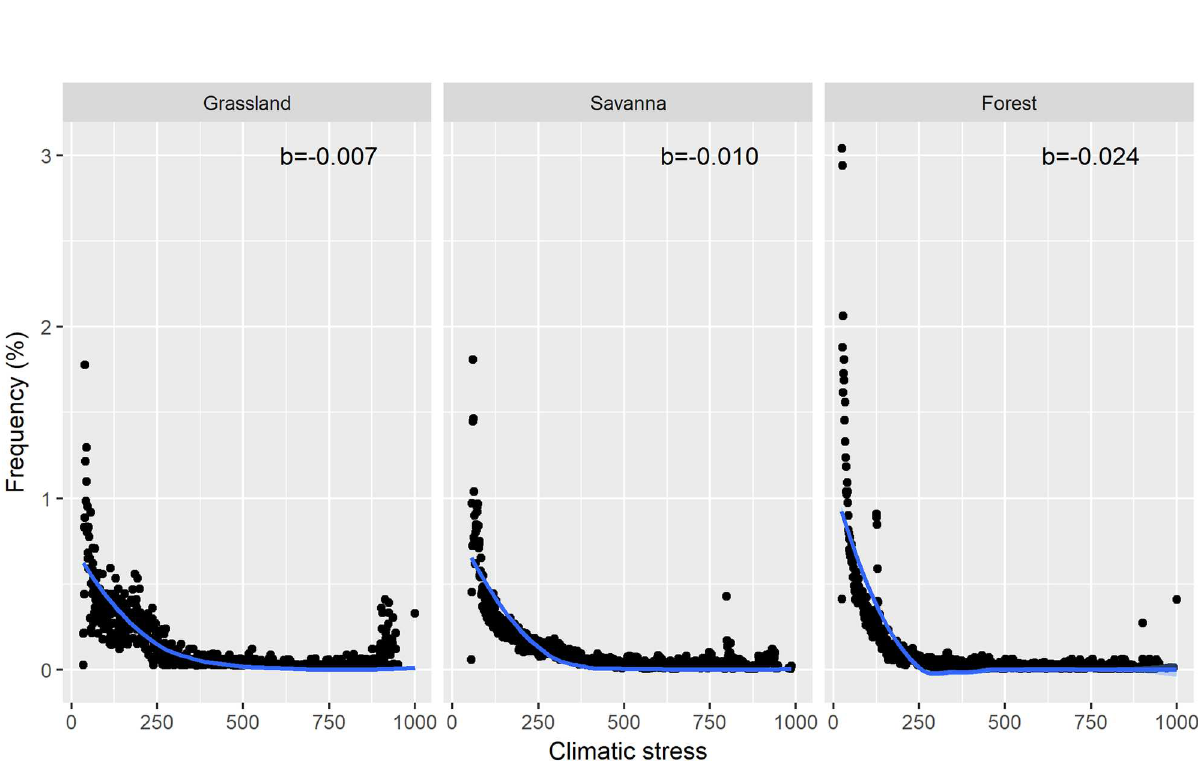
Fig 2. Model of ecosystem responses to a climate stress gradient based on the prediction of relative frequencies (%). The parameters of the exponential model indicate that there are differences regarding resistance to climatic stress among the three ecosystems. Grassland n = 598; Savanna n = 889; Forest n = 891.